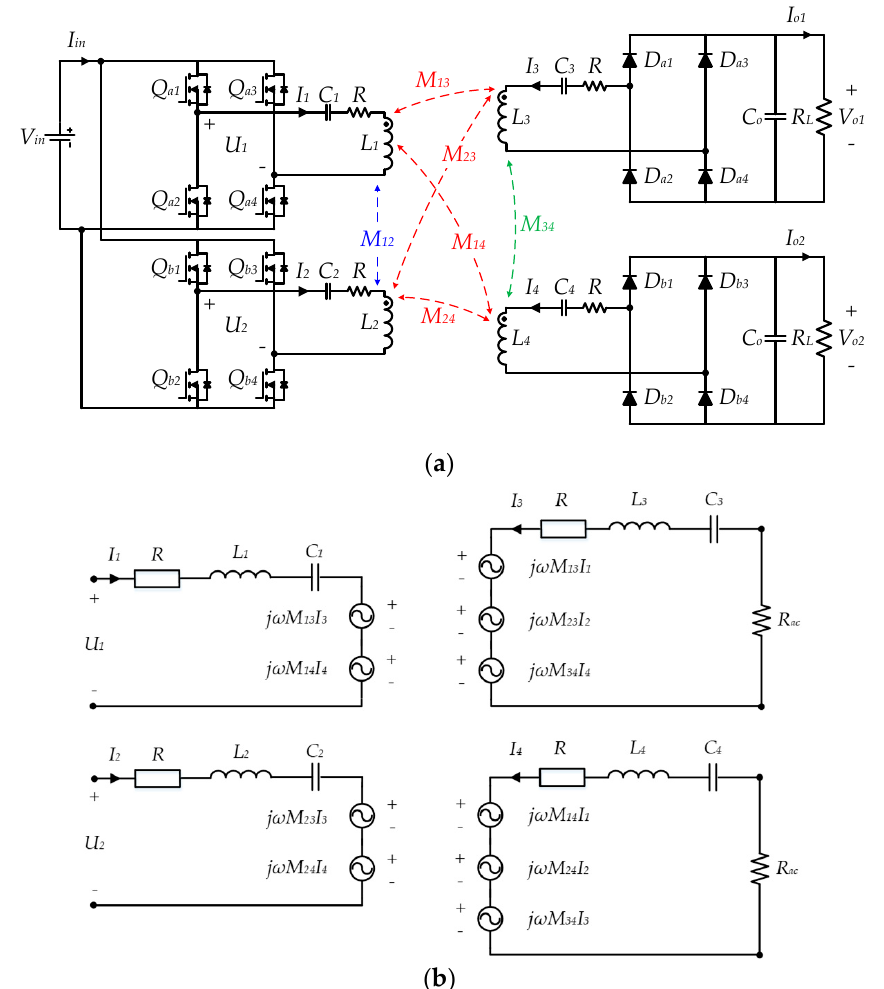
Figure 1. System configuration of multi-output omnidirectional wireless power transfer system.